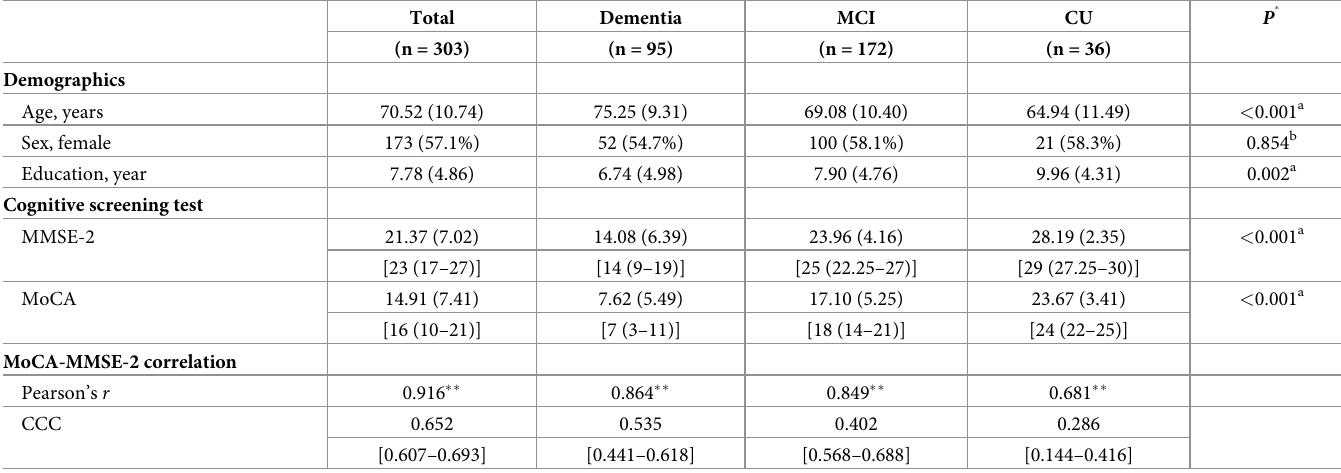
Table 1. Demographic data and MoCA and MMSE-2 scores and their